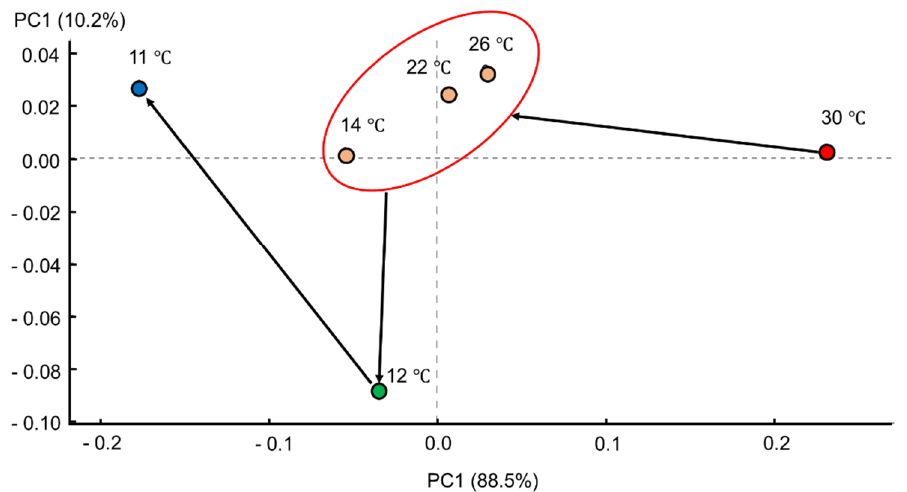
Figure 7. PCA plot of the differences in the genetic distance between the microbial community composition in the samples from the distinct experimental stages, validated with the ANOVA test using the STAMP software ( p < 0.05).